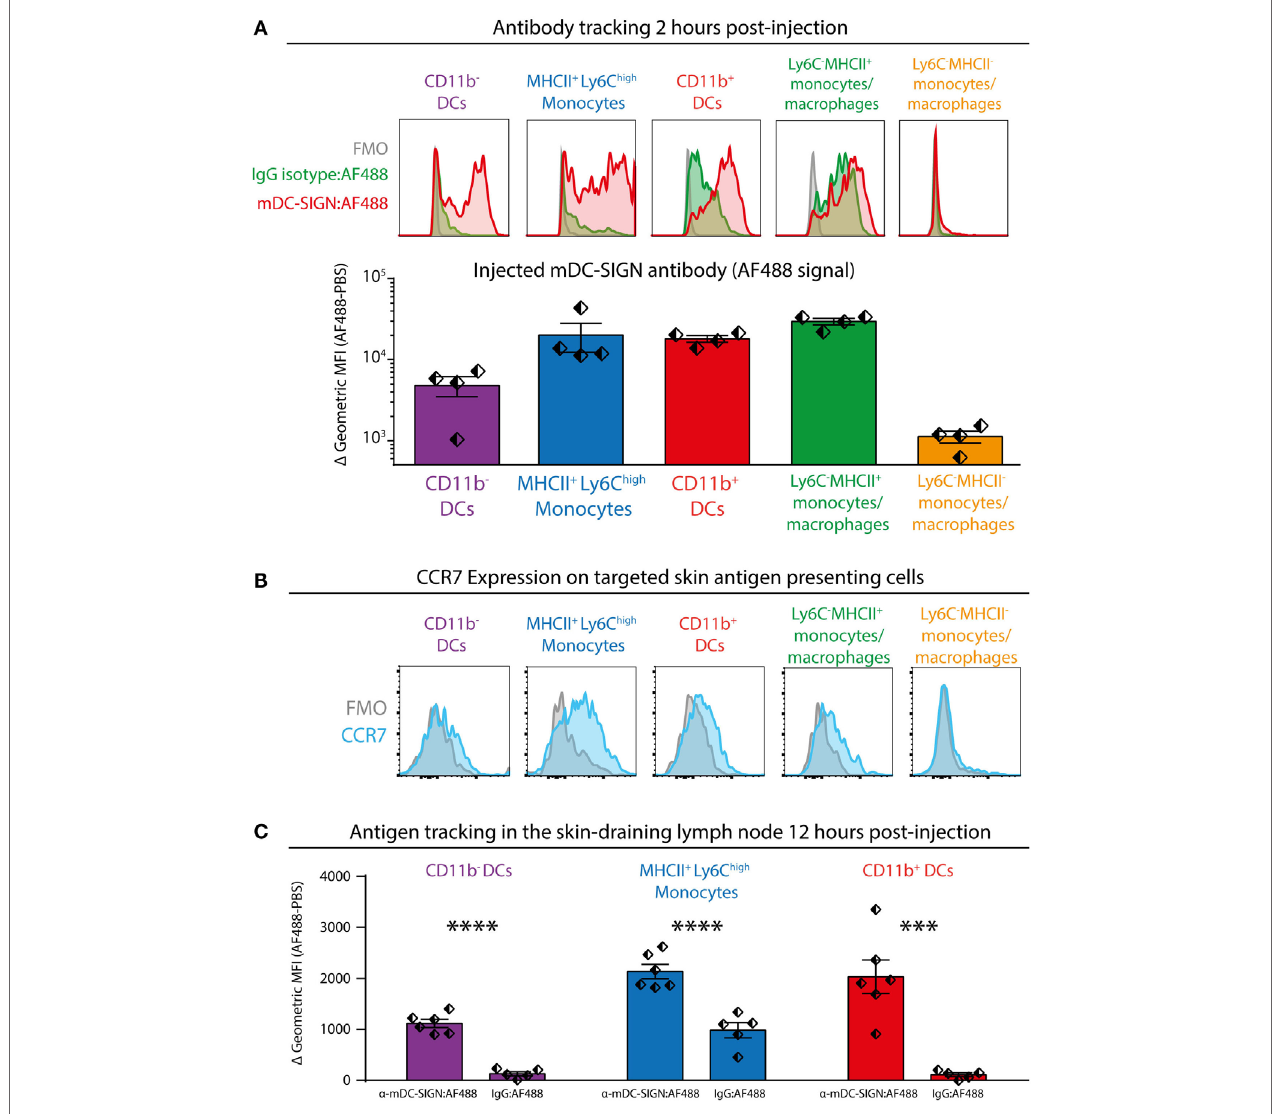
FigUre 5 | Subcutaneous injection of anti-mDC-SIGN antibody targets skin mDC-SIGN + antigen-presenting cells (APCs) primarily in the skin. (a) 2 h after subcutaneous injection of fluorescently labeled anti-mDC-SIGN in adjuvant (MF59/AddaVax with agonistic anti-CD40 antibody) shows targeting of skin APCs. mDC-SIGN antibody shows particular targeting of MHCII + Ly6C high monocytes, CD11b − and CD11b + dendritic cells. Red/green = fluorescent signal, gray = fluorescence-minus-one (FMO) negative control. (B) Expression of CCR7 on ex vivo isolated skin-derived antigen-presenting cells (APCs) 2 h after subcutaneous injection of anti-mDC-SIGN antibody. (c) Anti-mDC-SIGN-AF488 antibody-labeled APCs can be found in the skin-draining lymph node (LN) 12 h after injection. Data represented as mean ± SEM, analysis of variance with Tukey post hoc *** P < 0.001, **** P < 0.0001, representative of two individual